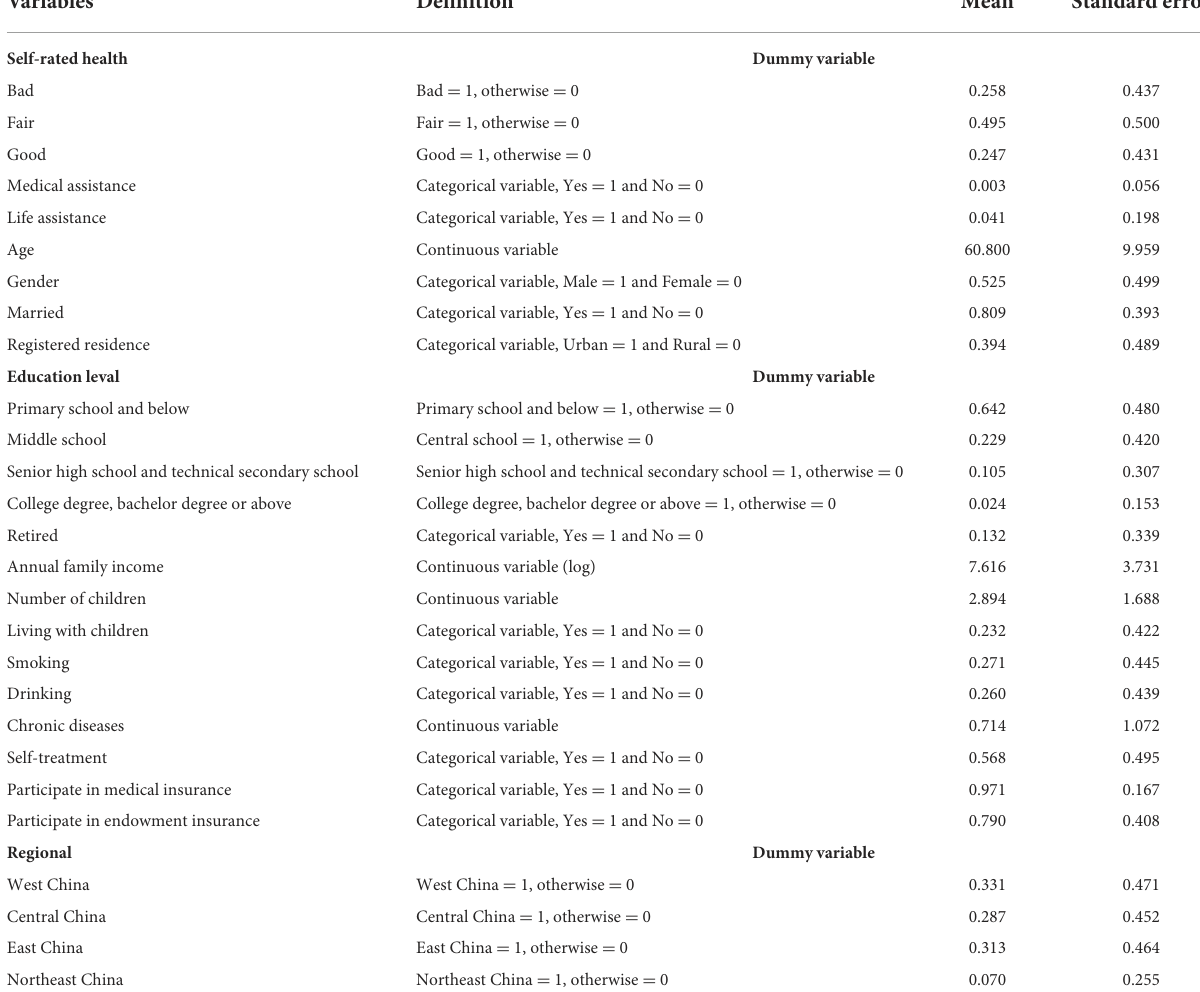
TABLE 1 Variable definitions and descriptive